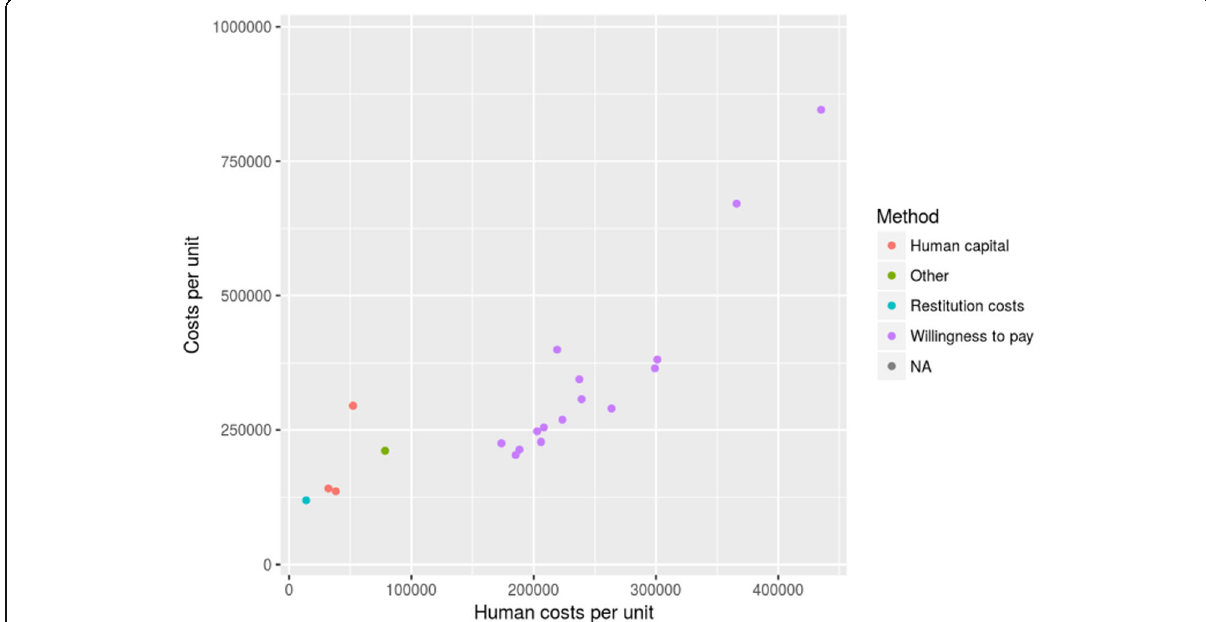
Fig. 4 Relation between cost per serious injury and human cost per serious injury, for different methods to calculate human costs (EUR 2015, adjusted for